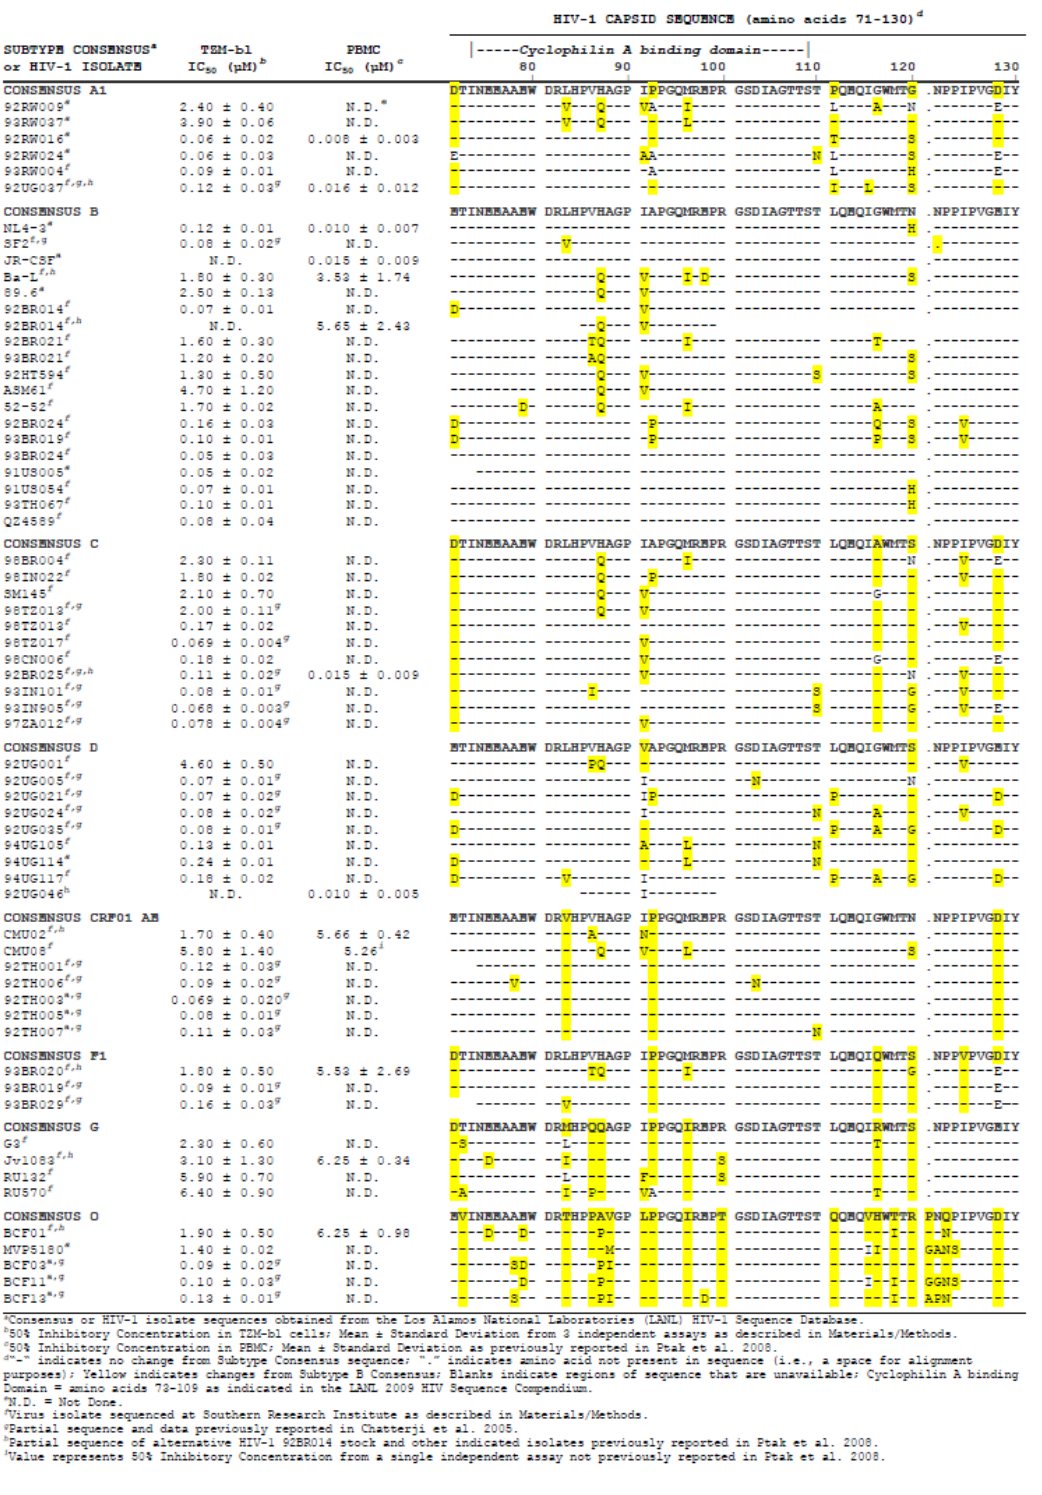
Table 1. Capsid polymorphisms in HIV-1 isolates and correlation with sensitivity to